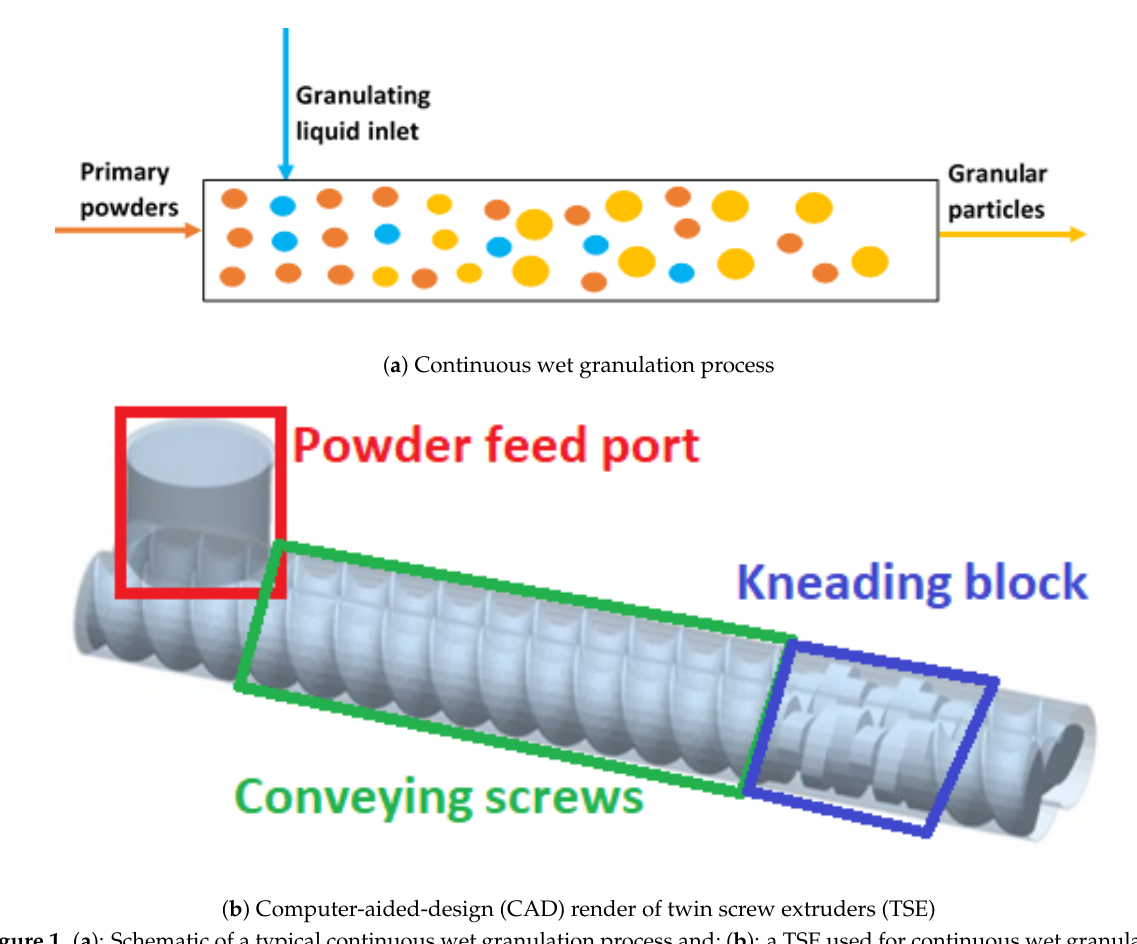
Figure 1. ( a ): Schematic of a typical continuous wet granulation process and; ( b ): a TSE used for continuous wet granulation